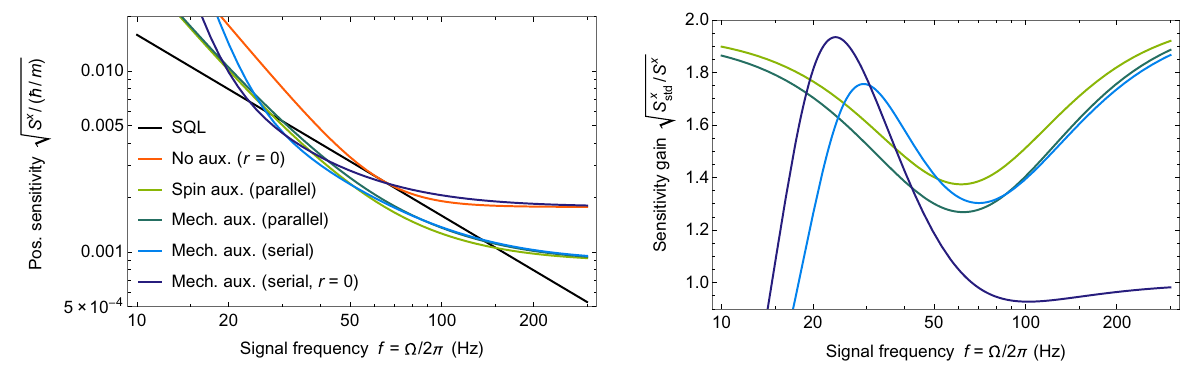
√ S x (71) improved by quantum noise evasion using an effective auxiliary oscillator